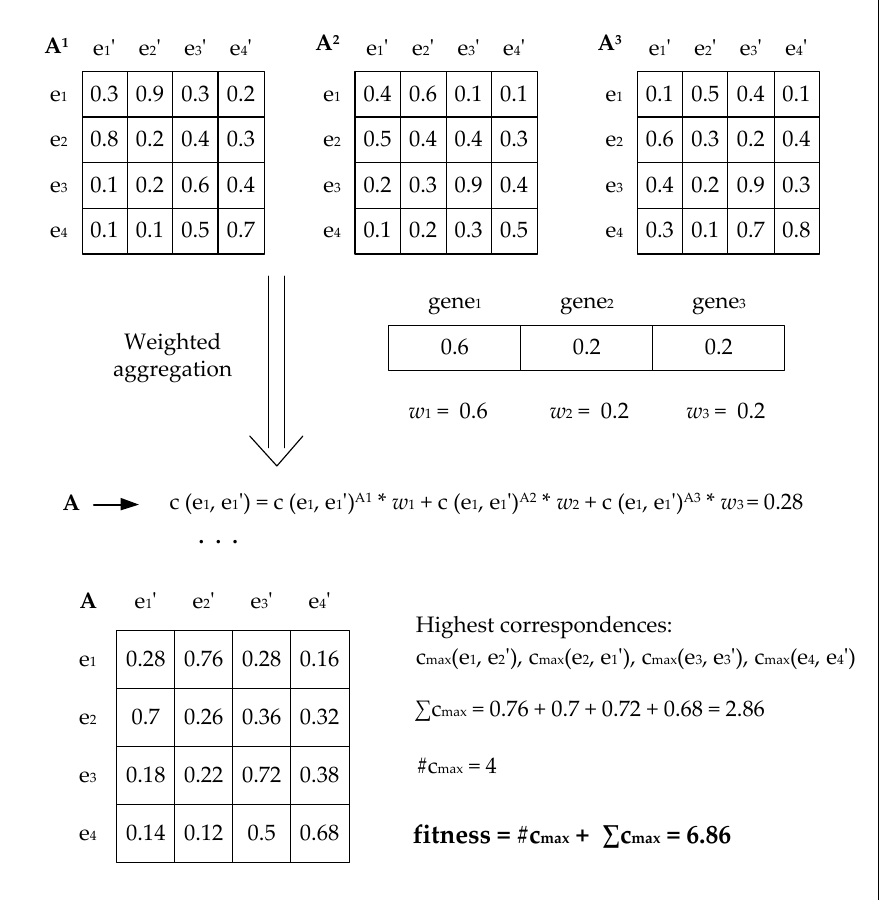
Figure 5. The calculation of the fitness function.